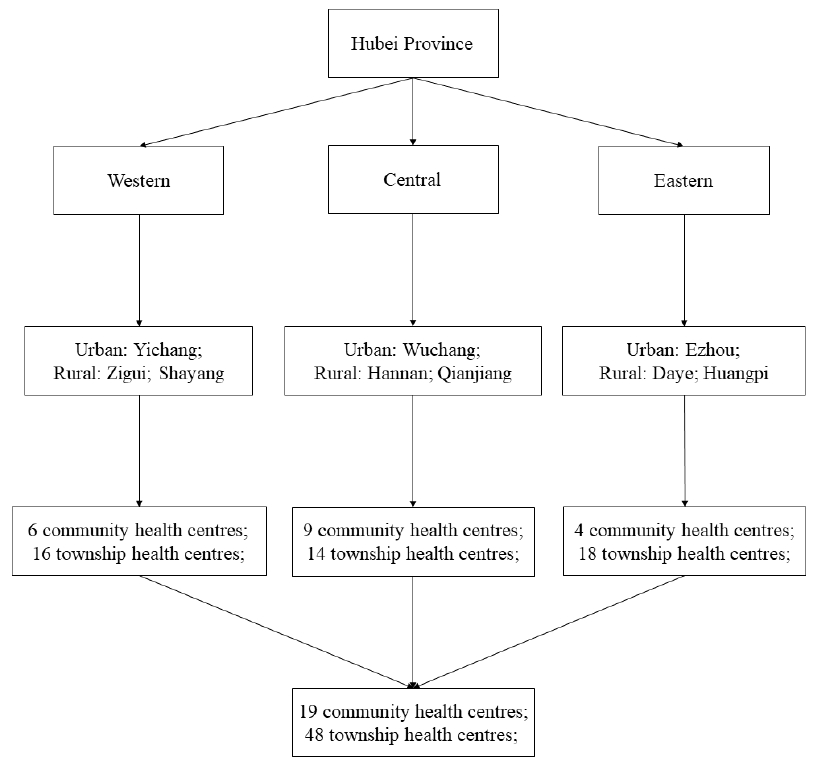
Figure 2. Sampling Figure 2. Sampling procedures.